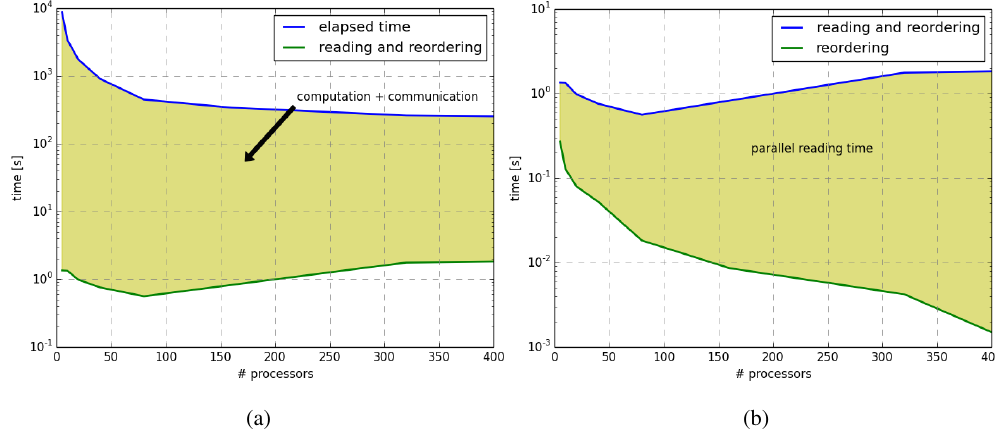
Figure 4. In (a) the overall runtime of the experiment in Fig. 3 (for τ = 0 . 5) is shown in the upper curve and compared to the time for parallel reading and reordering of time series (the lower curve). The shaded area corresponds to real-cpu time for the calculation of the correlation matrix and the communication between processors. Both times for parallel reading and reordering preprocessing tasks are shown in (b).